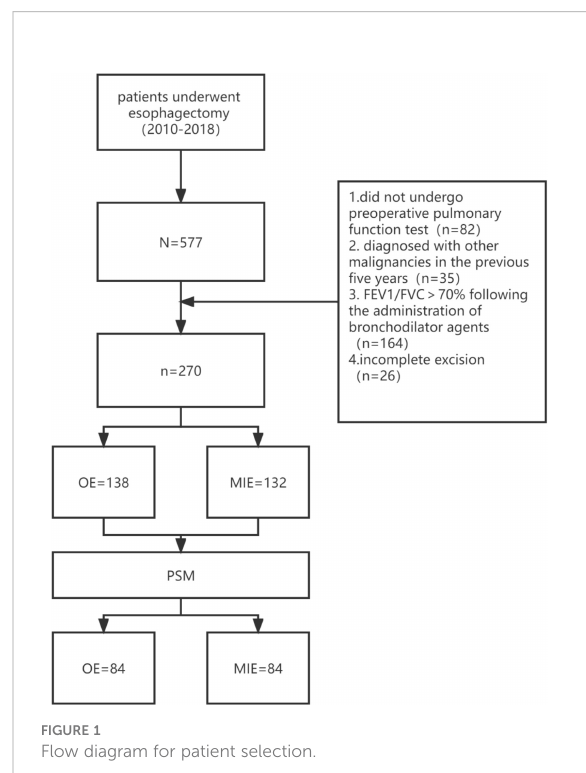
FIGURE 1 Flow diagram for patient